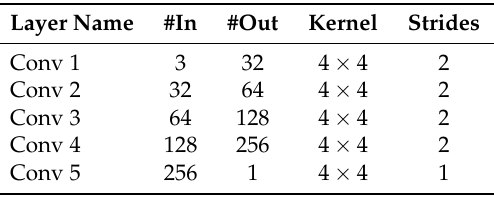
Table 2. Main parameters of our discriminator. ‘#In’ denotes the number of input channel, and ‘#Out’ represents the number of output